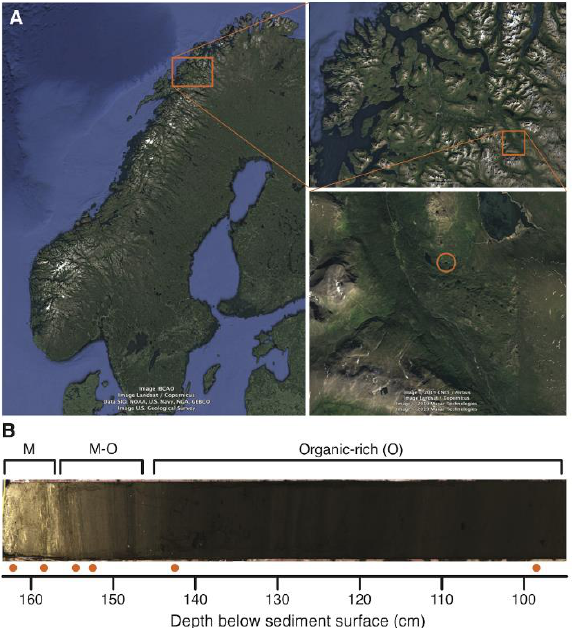
Figure A7. ( A ) Location of Lake Gauptjern in northern Norway. Map image from Google Earth (all map data sources and attributions are within the image). ( B ) Layers within the basal section of the Gauptjern core that were tested (orange circles). M, minerogenic-rich; O: organic-rich; M-O: minerogenic–organic.